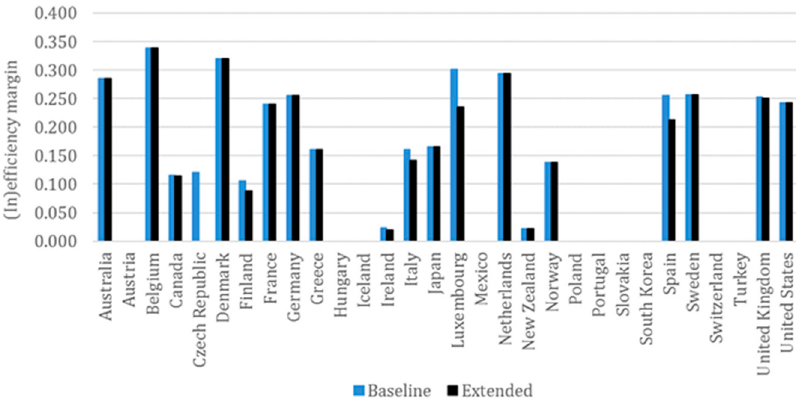
Figure A7. (In)efficiency scores for electricity.